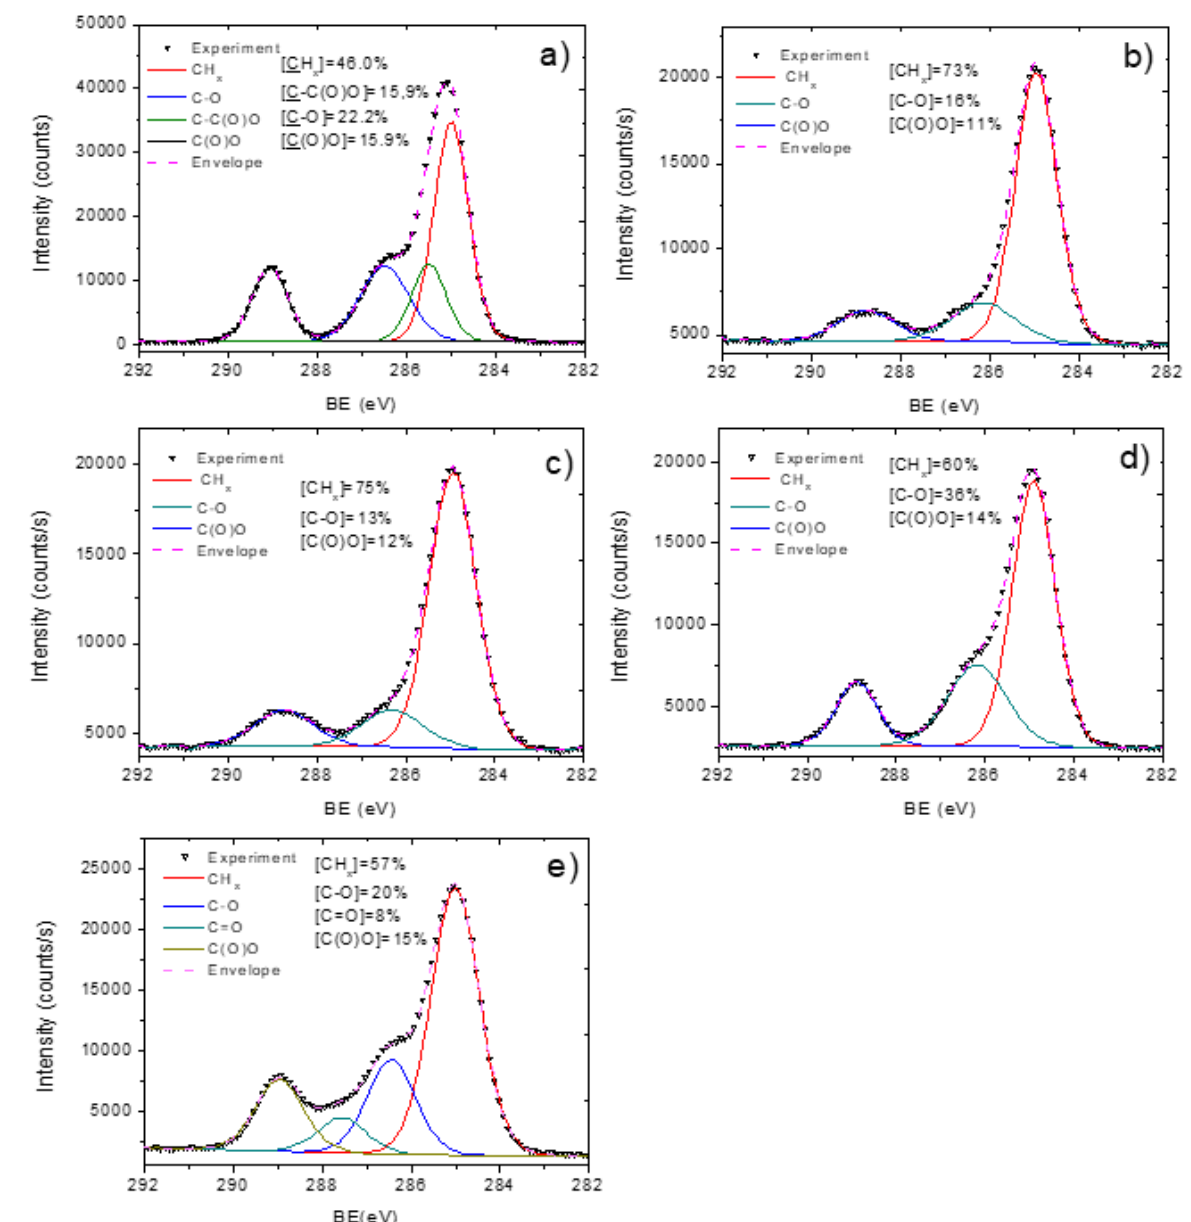
Figure 7. XPS C1s curve fitting of pristine PCL nanofibers PCL-ref ( a ), PCL-Cu as-deposited ( b ), PCL-Cu after two hours in PBS ( c ), PCL-Cu after 24 h in PBS ( d ) and PCL-Cu-COOH ( e ).